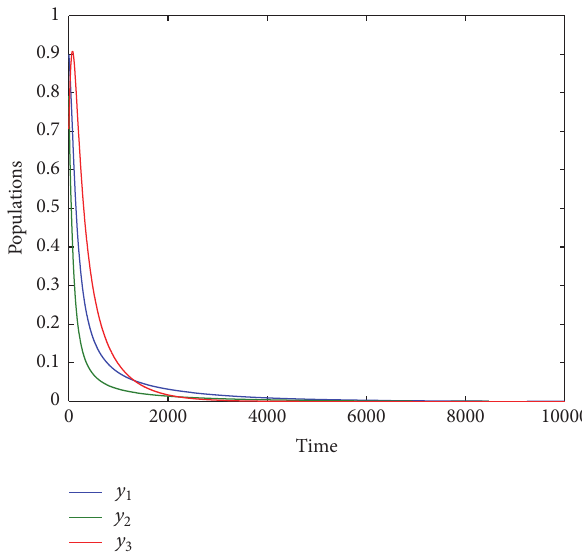
Figure 2: Time series of system (3) approaches asymptotically to the vanishing equilibrium point for 𝑎 1 = 0.8 with other parameters given by (69).